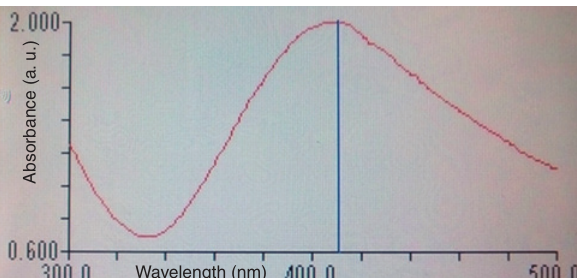
Figure 4: Overlaid contour plot of AgNPs particle size, concentra- tion with acceptable levels as a function of microwave exposure time, and amount of AgNO solution. 3